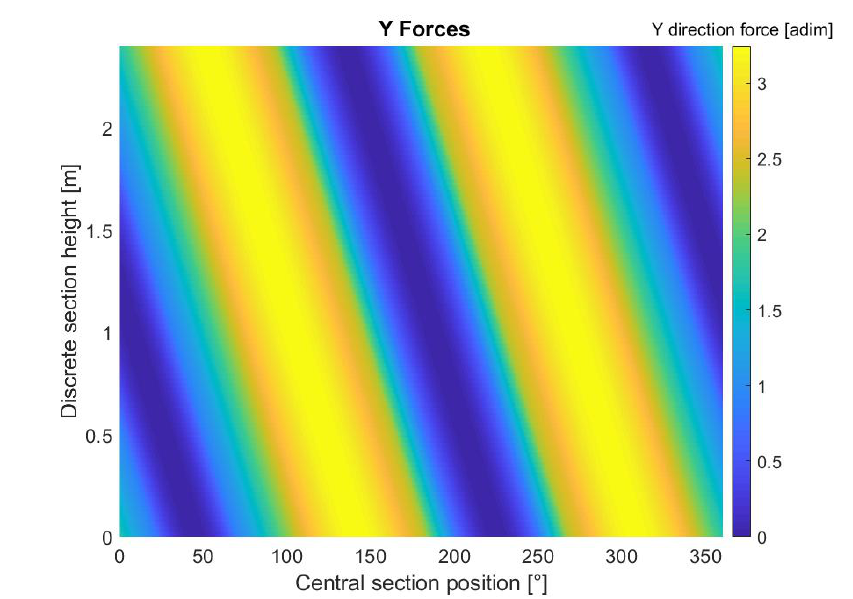
Figure 17. Distribution of y forces on discrete sections of blade. Values are